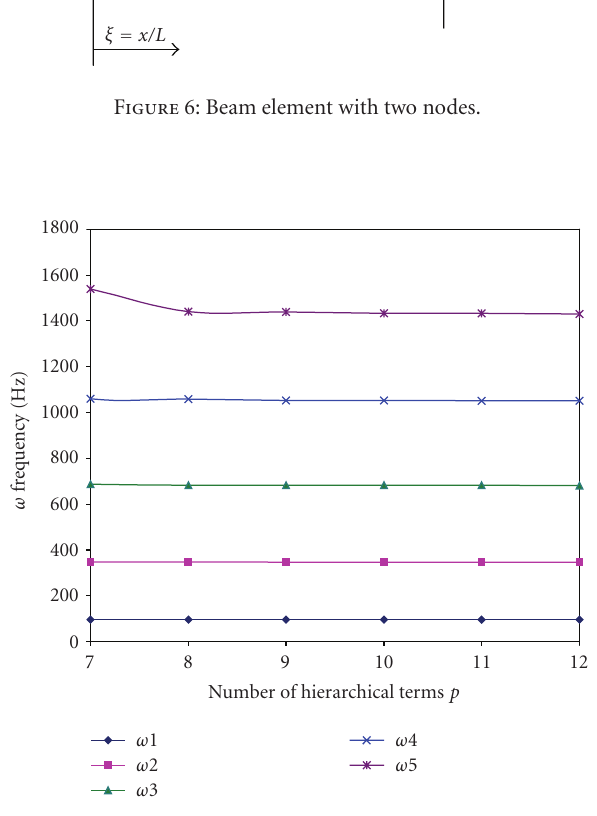
Figure 7: Convergence of the frequency ω for the 5 bending modes of the simply-supported (S-S) shaft as a function of the number of hierarchical terms p .